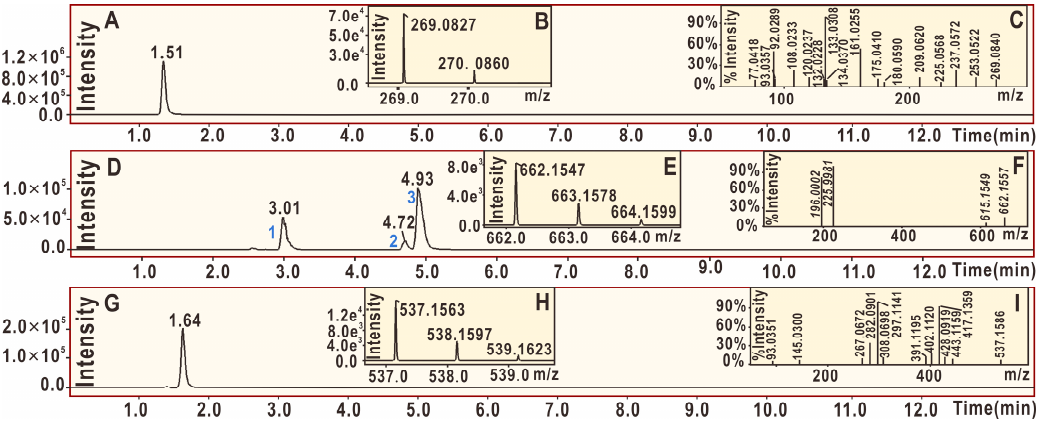
Figure 6. Main results of UPLC-ESI-Q-TOF-MS/MS analysis of echinatin: ( A ) total ion chromatographic diagram of echinatin; ( B ) primary MS spectrum of echinatin; ( C ) MS/MS spectrum of echinatin; ( D